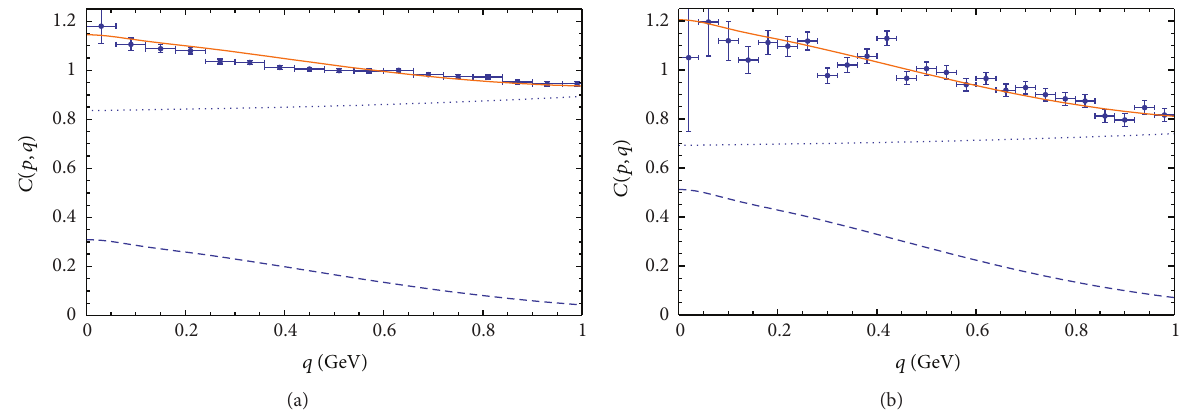
Figure 9: The nonfemtoscopic correlation functions of like-sign pions (a) from a simulation using PHOJET and unlike-sign pions (b) measured by the ALICE Collaboration in the 0.7 < 𝑝 𝑇 < 1.0 GeV bin from [41, 95] (solid dots) and those calculated from the analytical model (solid line). The contributions to the nonfemtoscopic correlation function from the first term of (56) (dotted line) and from the second one (dashed line) are also